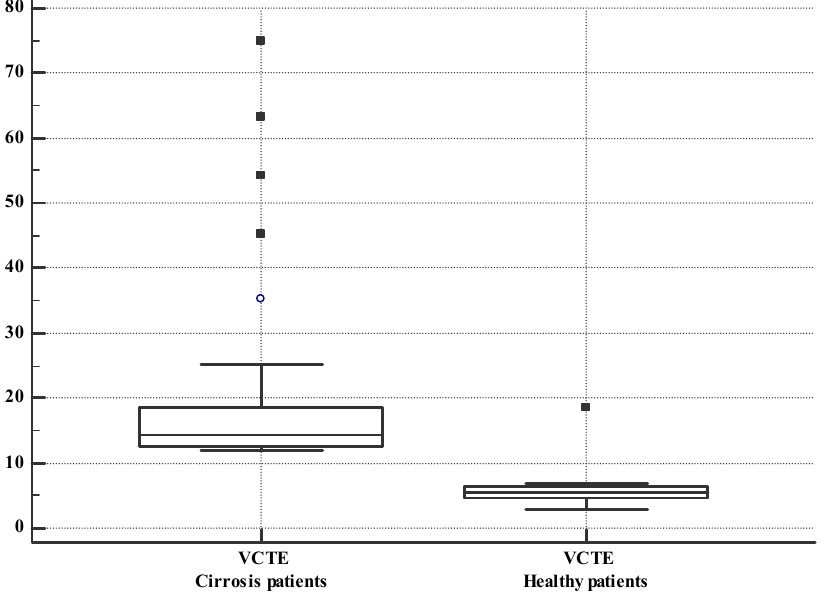
Figure 5. Box and whisker plot. VCTE measurements in cirrhosis patients and healthy volunteers. The boxes are proportional to the inter-quartile range (IQR) with medians marked in-between, and the whiskers are proportional to 1.5 * IQR (or trimmed to the minimum or maximum values). The bullet and the squares are outliers.